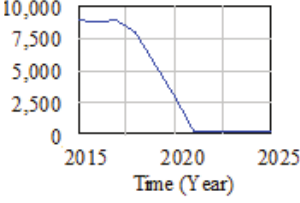
Fig. 12. Electricity import.